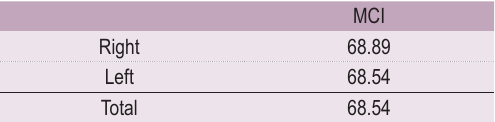
TABLE 4. Percentage of probability of exact identi fi cation